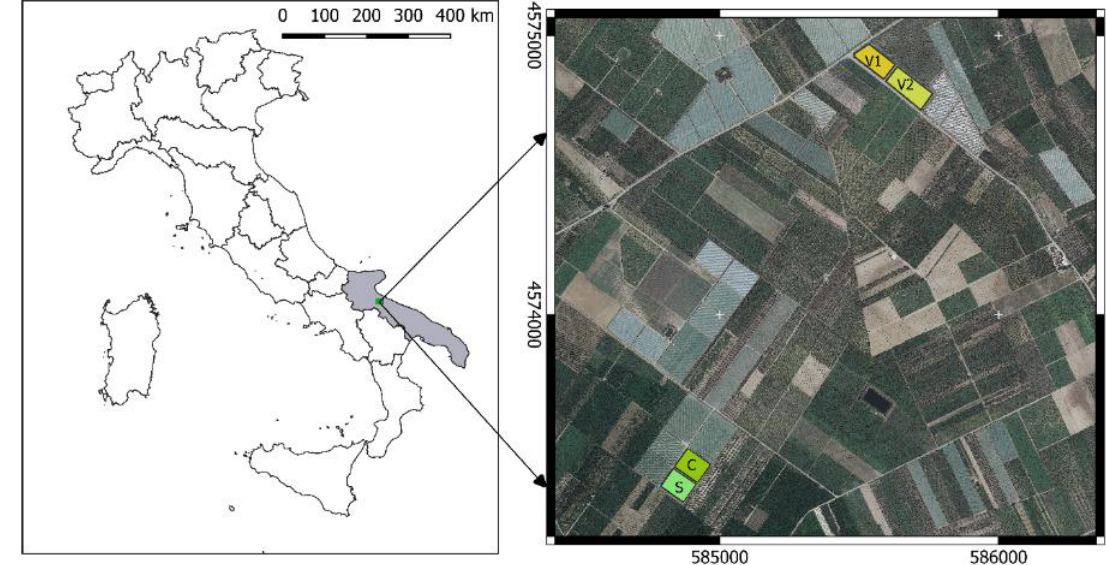
Figure 1. Test vineyards located in Apulia (SE Italy) close to Foggia area (S and C: vineyards covered with two types of plastic sheets; V1 and V2: uncovered vineyards).